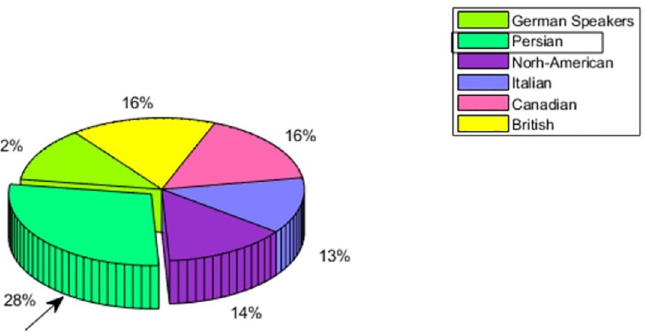
Fig 11. Persian speaker—Multicultural emotion accuracy comparison and In-group